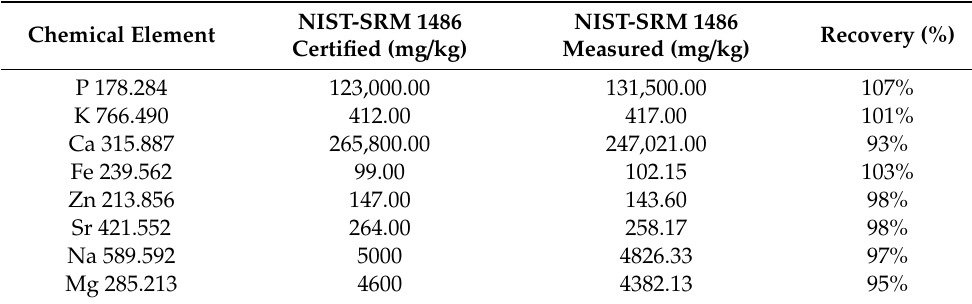
Table 1. Analysis of reference material bone meal NIST-SRM (National Institute of Standards and Technology-Standard Reference Material)1486 using inductively coupled plasma optical emission spectrometry (ICP-OES).